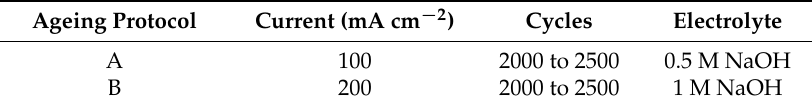
Figure 1. Typical design of experimental electrolytic cell, based on laser-cut components. Table 1. Different accelerated ageing protocols employed.